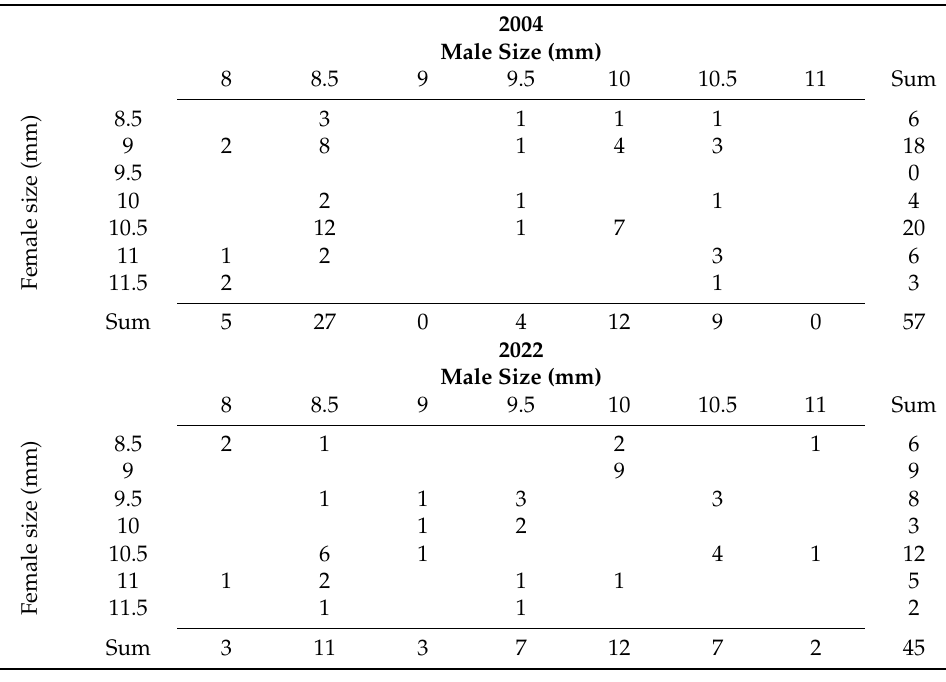
Table 1. Size of males and females put together in experimental pairs. The figures indicate the number of pairs that survived until the start of the oviposition, in the 2004 and 2022